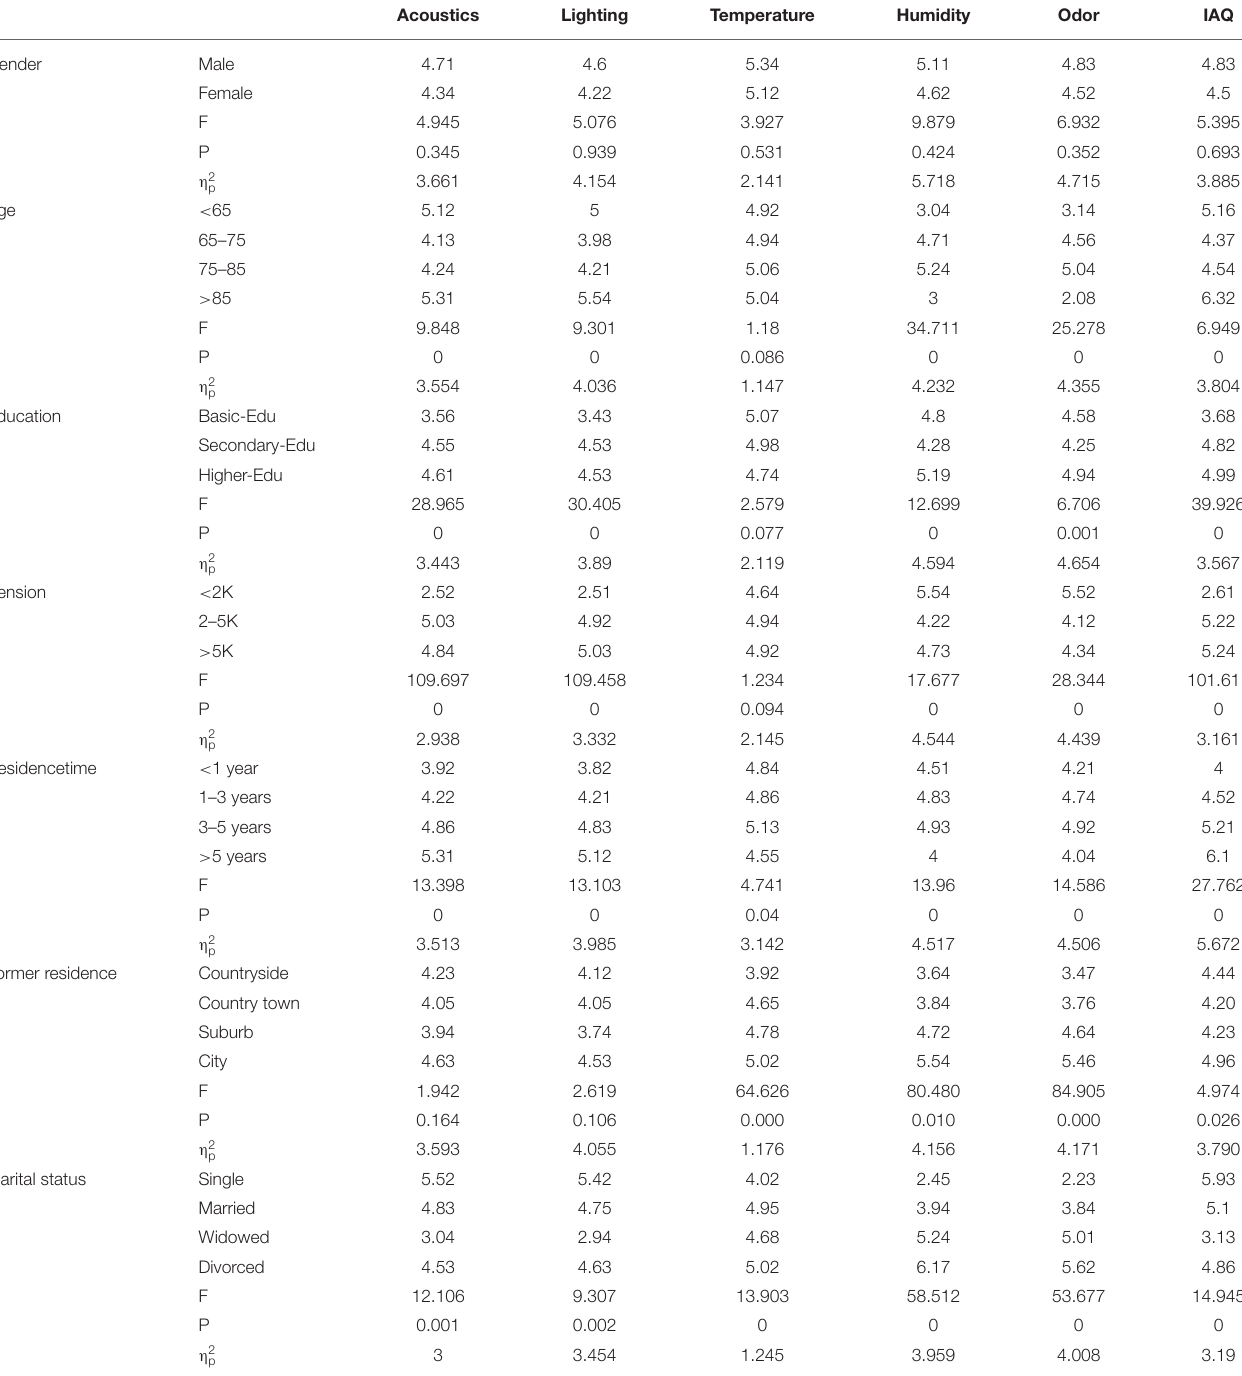
TABLE 6 | Relationship between IEQ evaluations value and residents’ background. Acoustics Lighting Temperature Humidity Odor